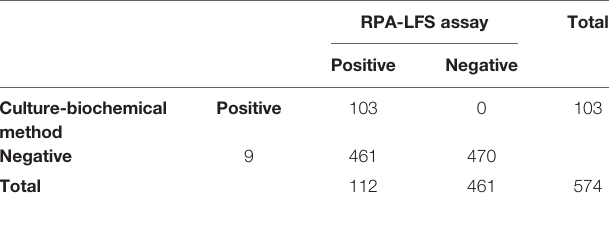
TABLE 5 | Determination of coincidence rate between RPA-LFS assay and culture-biochemical methods in clinical